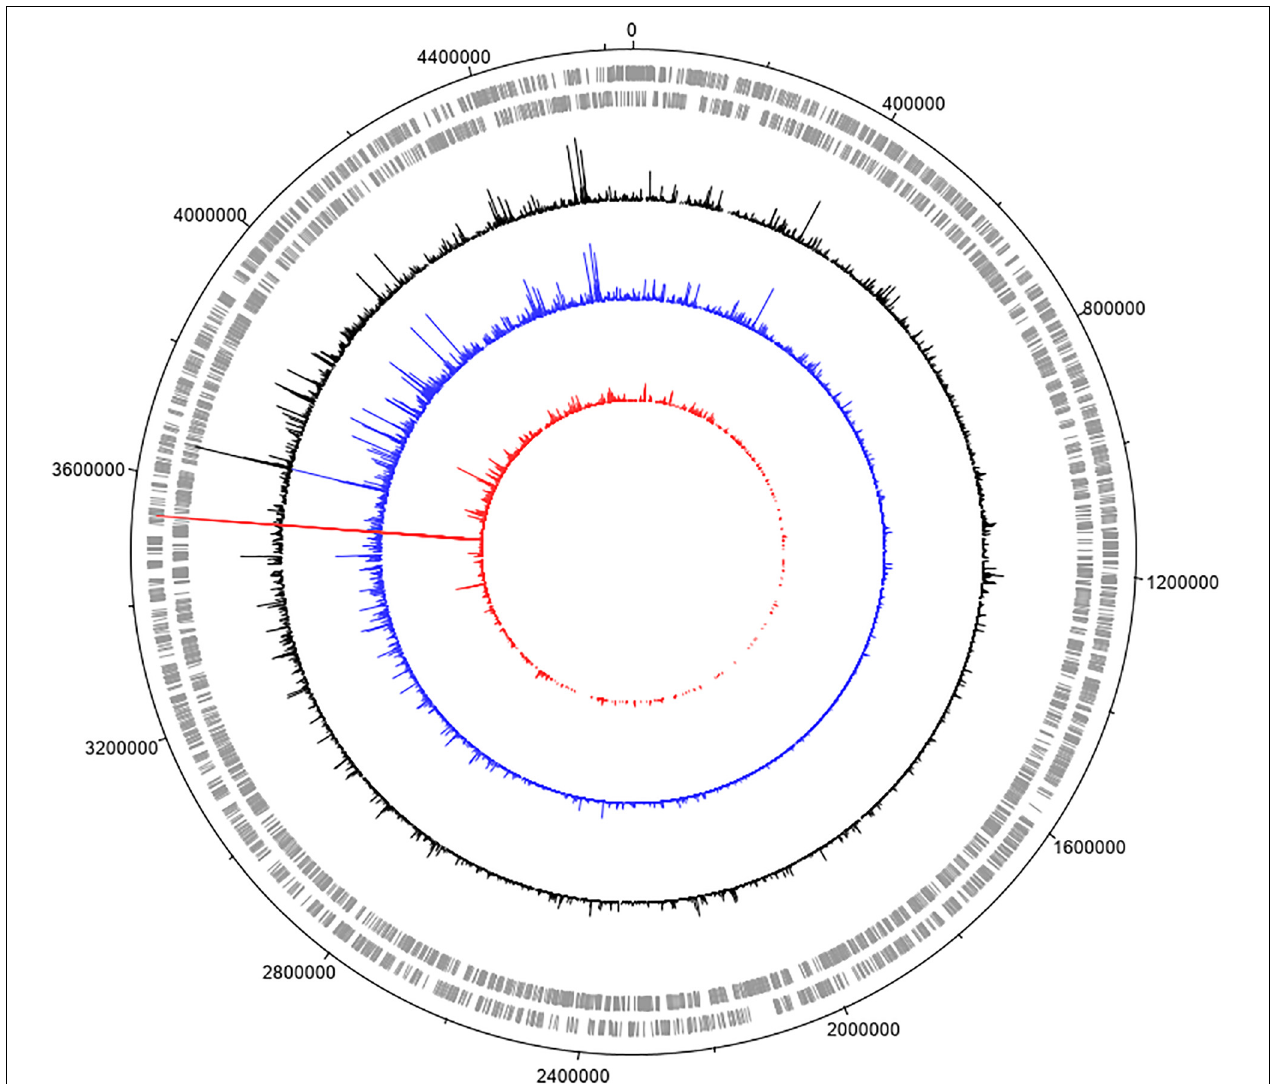
FIGURE 2 | Genome-wide transposon insertion sites mapped to E. coli strain MG1655 in the TraDIS library. Frequency and location of transposon junction sequences from a mini-Tn 5 transposon library in strain MG1655, mapped to the MG1655 genome (CP009273.1). The outermost track marks the MG1655 genome in base pairs starting at the annotation origin. The next two inner tracks correspond to sense and antisense CDS, respectively. The innermost circles correspond to the frequency and location of transposons mapped to the MG1655 genome. The circles represent the initial MG1655 transposon library (black), and the library after 30 min (blue) and 90 min (red) exposure to model honey. The figure was created using